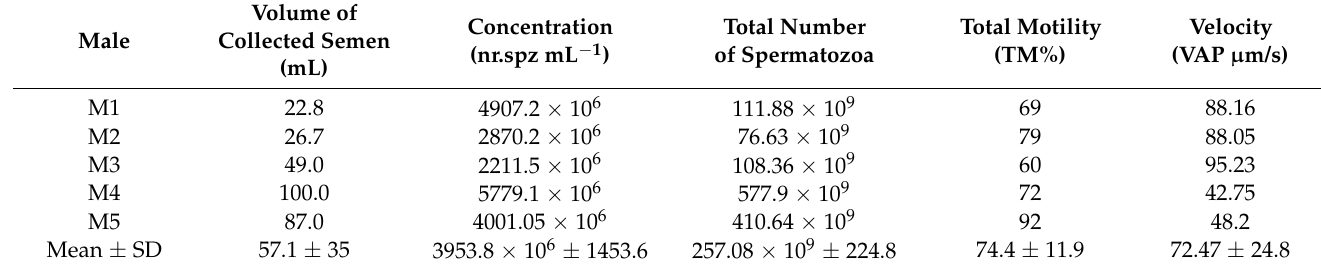
Table 2. Sperm parameters recorded in Russian sturgeon semen samples immediately after